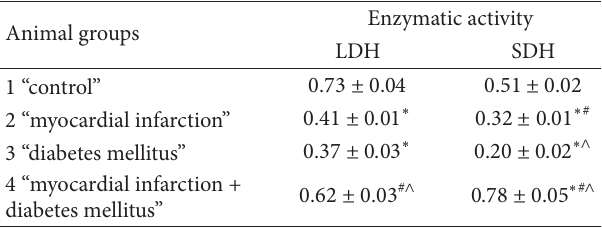
Table 2: Enzymatic activity in myocardium of animals from the observation groups ( 𝑋 ± 𝑚) .